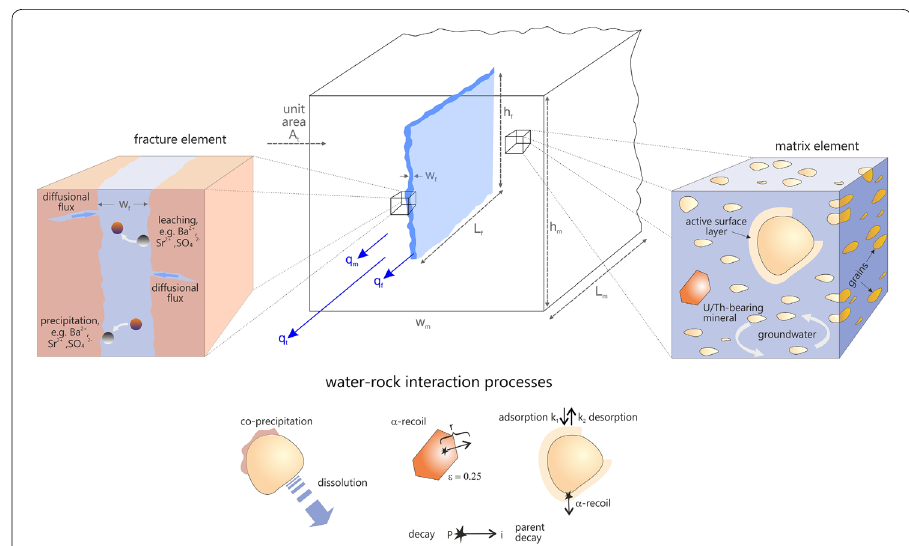
Fig. 9 Conceptual model for the Bruchsal geothermal site: Fracture-dominated radionuclide transport within the reservoir section in consideration of the physico-chemical water–rock interactions (adsorption– desorption, dissolution–precipitation, alpha-recoil) which take place to varying extent in both, the fracture and matrix element (figure extended after Tricca et al. 2000)